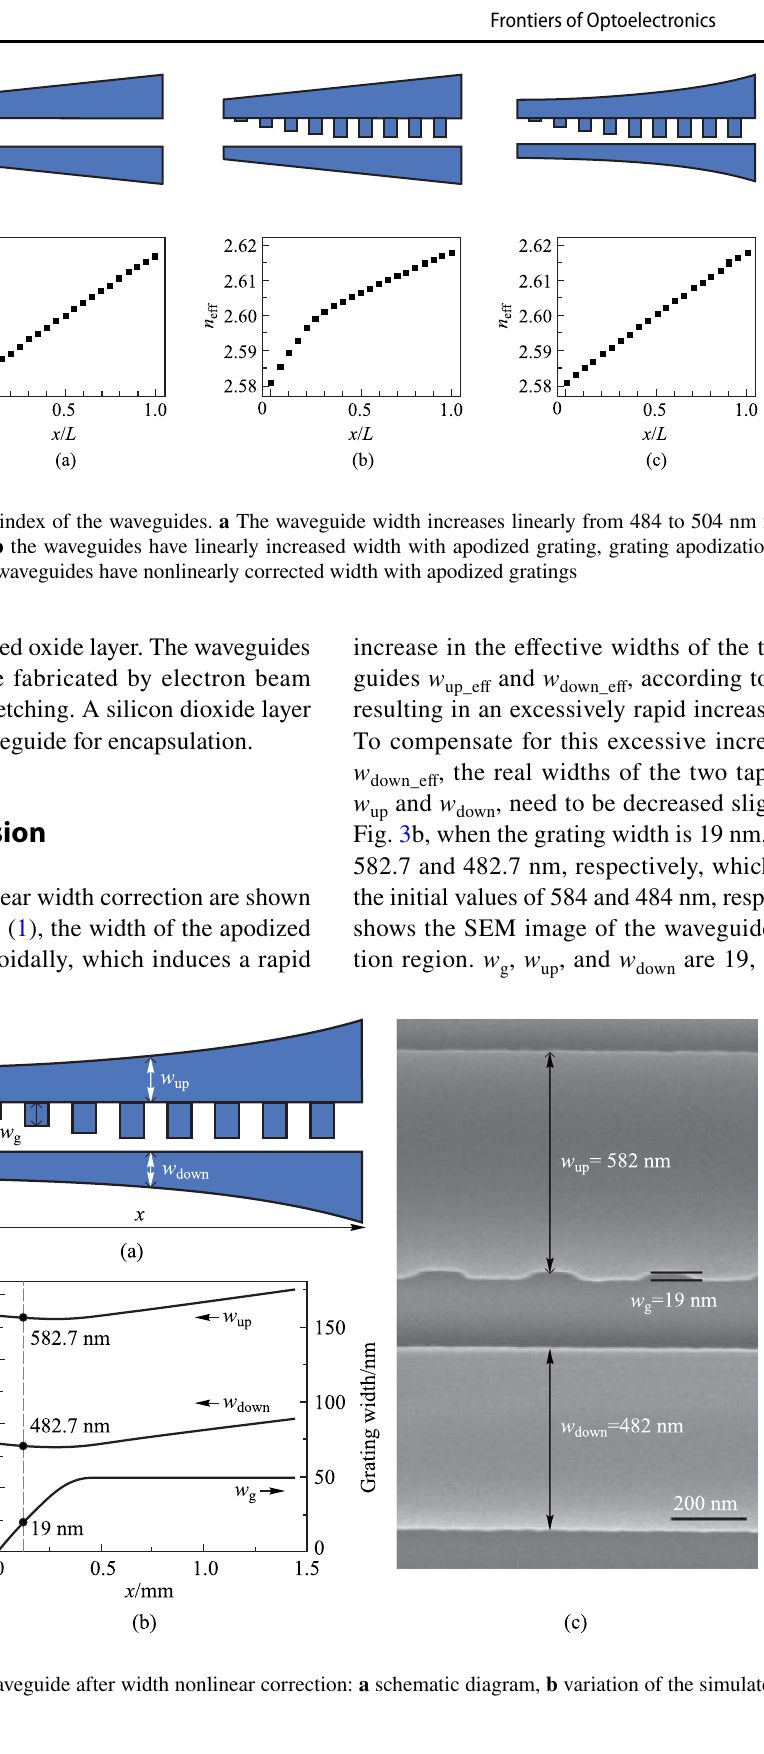
w w up , down , and g ,